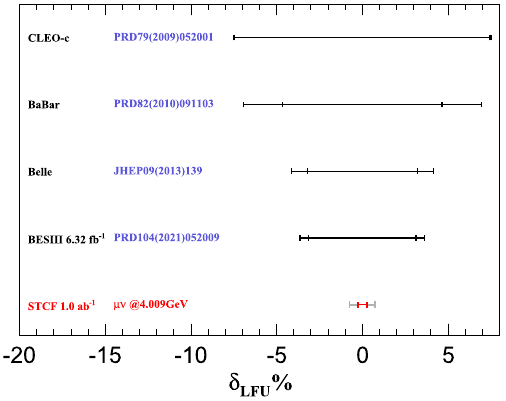
Fig. 8 The comparison of δ LFU with previous measurements, the red regionrepresents thestatisticsuncertaintyandthegreyarethoseinclud- ing systematic